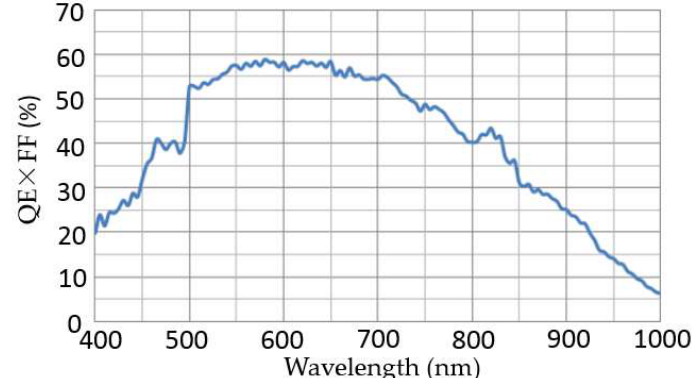
Figure 1. Spectral response curve for the detector.